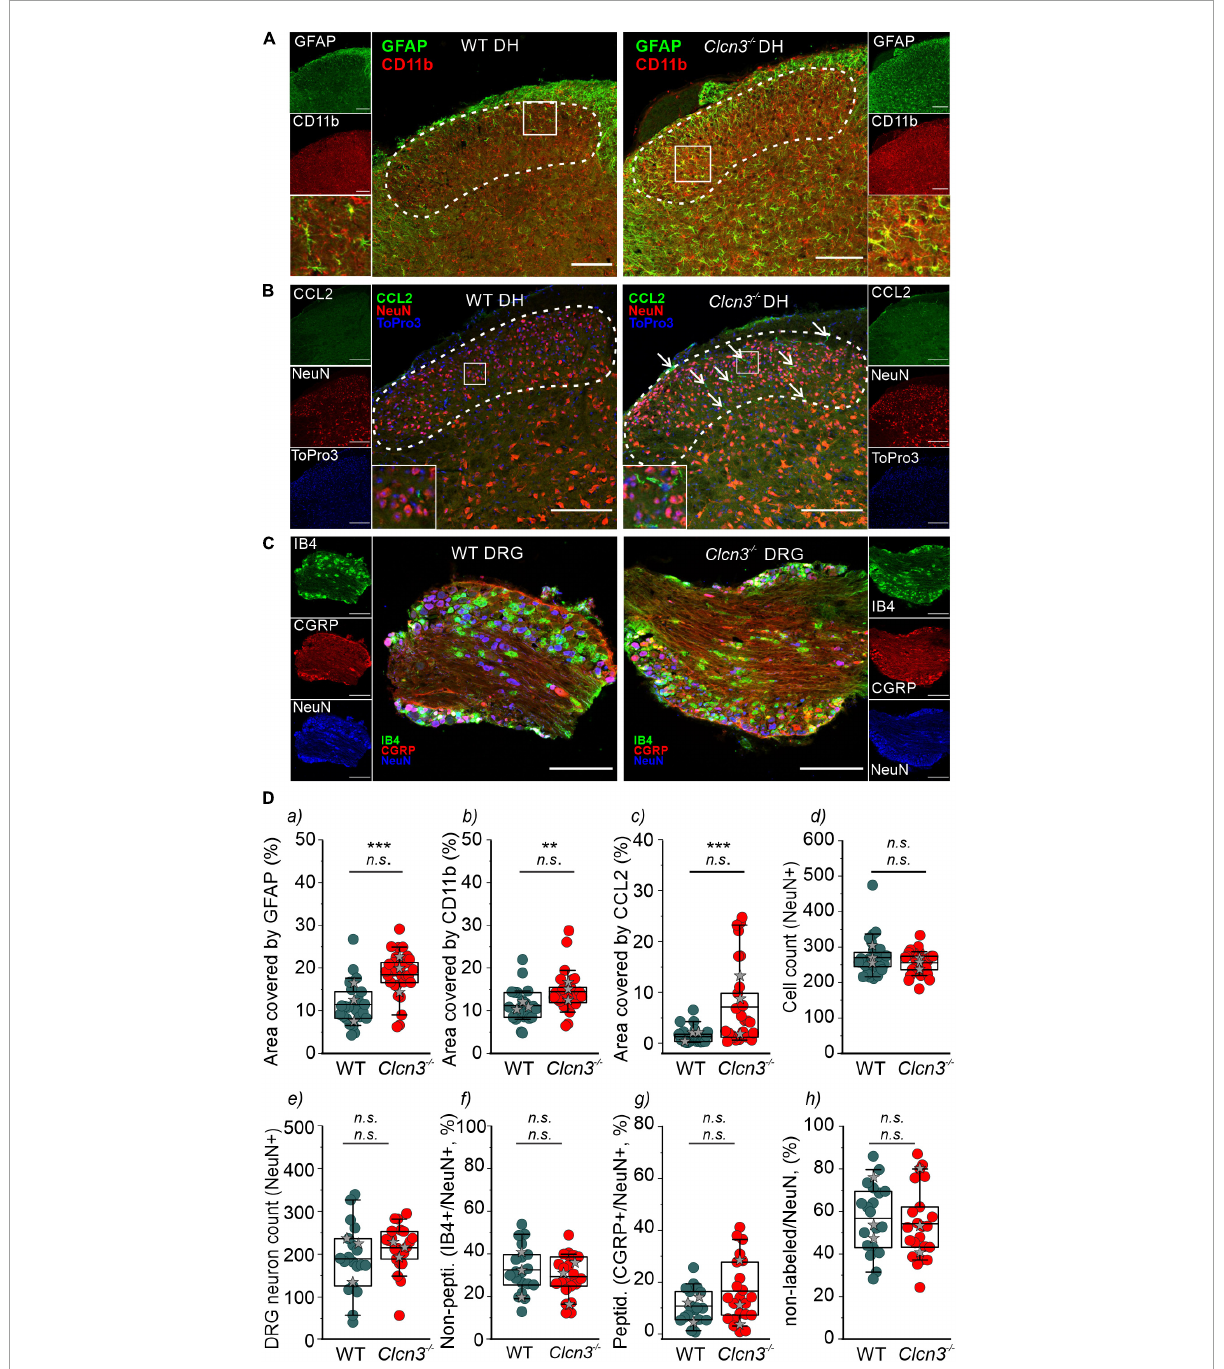
FIGURE5 ClC-3 disruption leads to neuroinflammation within the DHSC. (A) glial fibrillary acidic protein (GFAP) and CD11b positivity in the dorsal horn (DH) layers I–IV of wild type (WT) and Clcn3 − / − mice. (B) Section of the lumbar spinal cord from WT and Clcn3 − / − mice stained for CCL2 (green), NeuN (red), and TO-PRO-3 (blue, nuclei). (C) Representative immunofluorescence confocal images of dorsal root ganglia from WT and Clcn3 − / − mice stained for NeuN (blue), IB4 non-peptidergic small-diameter (green), and CGRP peptidergic (red) neurons. (D) (a) Area of glia expressing GFAP, (b) activated microglia expressing CD11b, (c) area of neuronal CCL2 expression, and (d) neuronal count in the dorsal horn from WT and mutant spinal cords. (e–h) Quantitative analysis of the total neuron count within the dorsal root ganglion (DRG). Each dot represents a single measurement, (a–d) WT ( n = 29), Clcn3 − / − ( n = 33); (g, h) WT ( n = 23), Clcn3 − / − ( n = 29). Three or four mice were used per genotype, with at least six slices from the lumbar section of each animal. Sections were 20- µ m thick and collected every 100 µ m apart. Scale bar: 200 µ m. Statistical significance levels are ** p < 0.01, *** p < 0.001, n.s., not significant. Clcn3 − / − differs from WT using the Student’s t- test (upper symbol), and statistics per animal with the data displayed with gray stars (lower symbol). In boxplots, boxes indicate the upper and lower quartiles, and whiskers the upper and lower 90